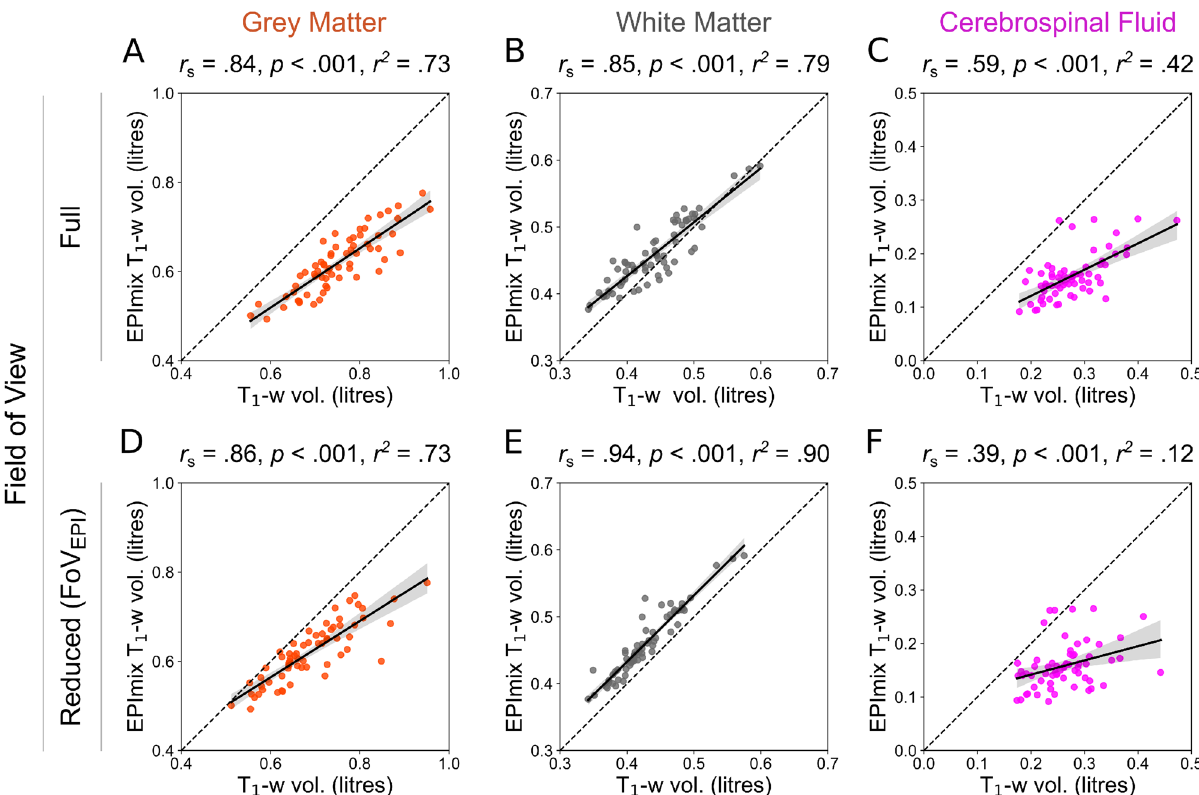
Figure 1. Global tissue volume estimation across contrasts. Comparison of tissue volumes (grey matter, white matter and cerebrospinal fluid) between T 1 -w and EPImix (T 1 -w) scans with full field of view ( A – C ) and between EPImix (T 1 -w) scans and T 1 -w scans with reduced field of view ( D – F ). (Spearman’s correlation coefficient r s , p -value, r 2 derived from Pearson’s